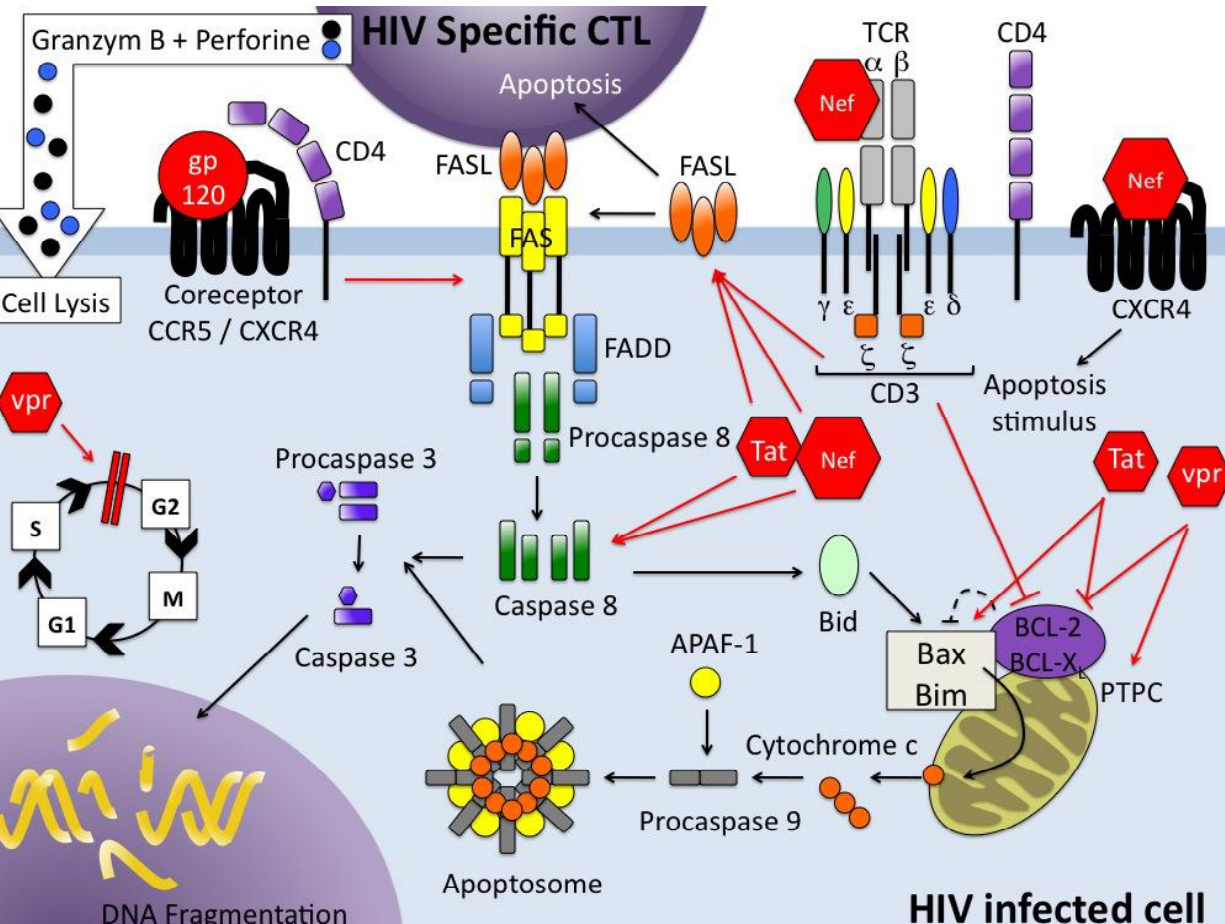
Figure 1. The extrinsic (death receptor-mediated) and intrinsic (mitochondria-mediated) pathways that lead to apoptosis of HIV infected helper T cells. The main HIV proteins (in red) implicated in CD4 + T cell death are the envelope glycoprotein gp120, the negative effector Nef, the transactivator of transcription (TAT) and the viral protein R (vpr). HIV gp120 uses CD4 on helper T cells and the chemokine receptors CCR5 or CXCR4 as coreceptors for virus cell entry and upregulates Fas-ligand (FASL) on these cells. Soluble Nef protein interacts directly with CXCR4 to induce cell apoptosis. Exogenous Nef protein directly stimulates TCR-CD3 complex and upregulates Fas/FasL expression on the cell surface while inhibiting the anti-apoptotic proteins Bcl-2 family. As endogenous Nef protein, Tat upregulates the Fas/FasL pathway and directly activates caspase 8. Tat and Vpr inhibit bcl-2 family while increasing mitochondria dysfunctions and cytochrome c release that promotes the formation of the apoptosome. HIV-1 Vpr also arrests cells in the G2 phase of the cell cycle. TCR: T cell receptor; CTL: cytotoxic T lymphocyte; FasL: Fas ligand; FADD: Fas-associated death domain; Caspase: cysteinyl aspartic acid-protease; BCL-2: B-cell lymphoma protein 2; BCL-X: BCL-2 like 1; Bax: BCL2 associated X protein; APAF: Apoptotic protease activating factor; PTPC : permeability transition pore complex.